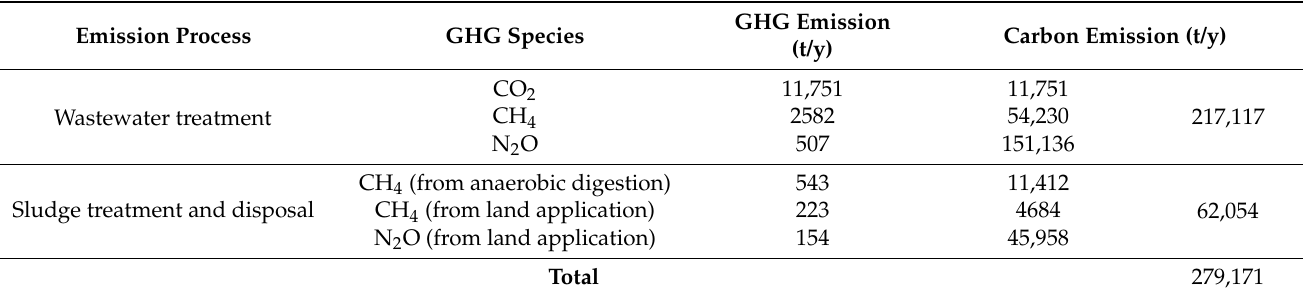
Table 5. Direct carbon emissions from Gaobeidian